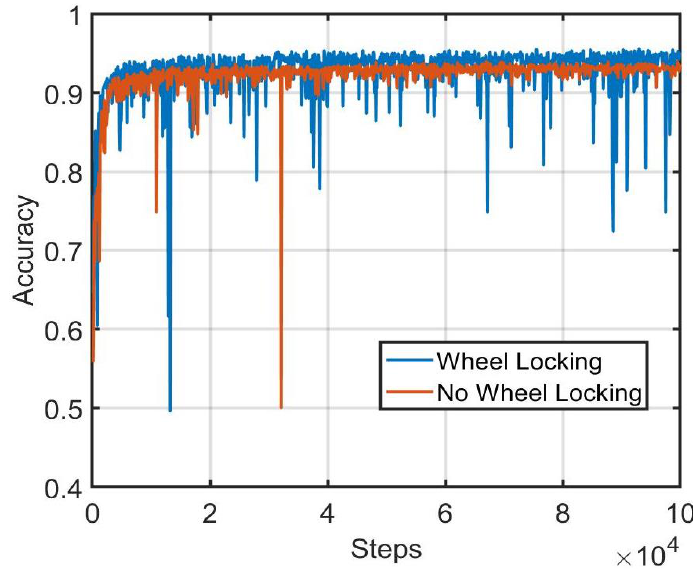
Figure 7. Comparison of validation set performance during training between wheel-locking and non-wheel-locking preprocessing approaches.